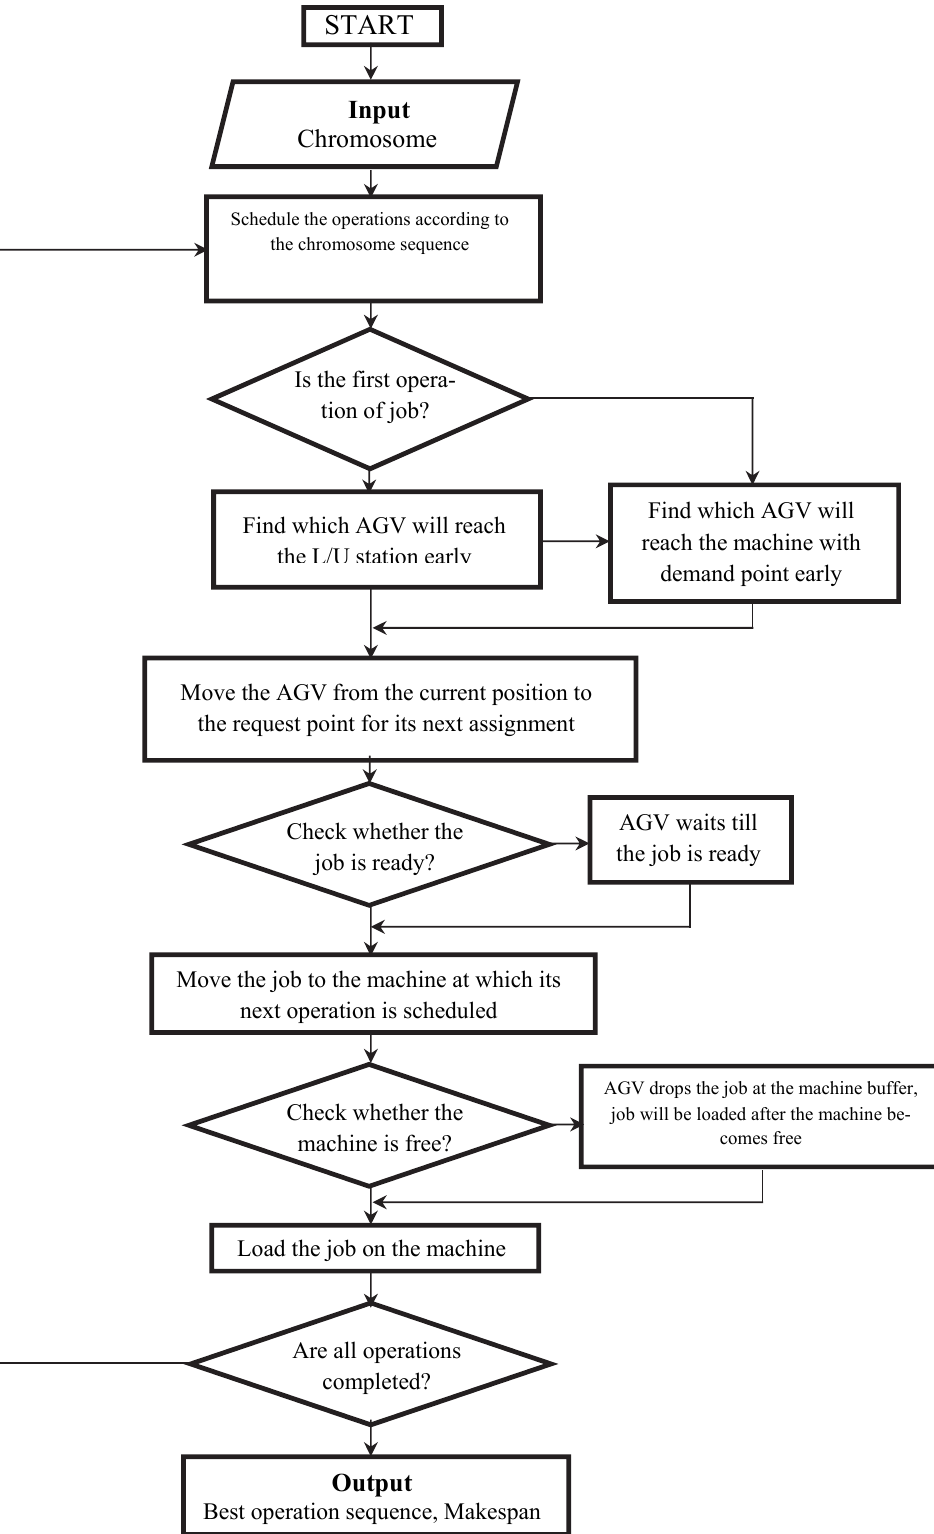
Fig. 2. Flow Chart for Synchronized scheduling of machines and